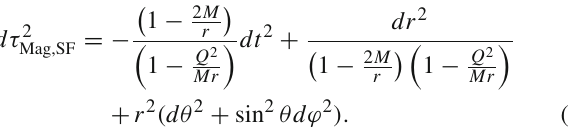
Fig. 1 The effective potential V eff ( r ) for a GMGHS BH in the EF ( a ), magnetically charged one in SF ( b ), electrically charged one in the SF ( c ) and Reissner–Nordström BH ( d ). The specific angular momen- tum of the orbiting particle is chosen to be (cid:5) L = 4 M . The potentials √ for Q < 2 M do not show appreciable difference with those of the